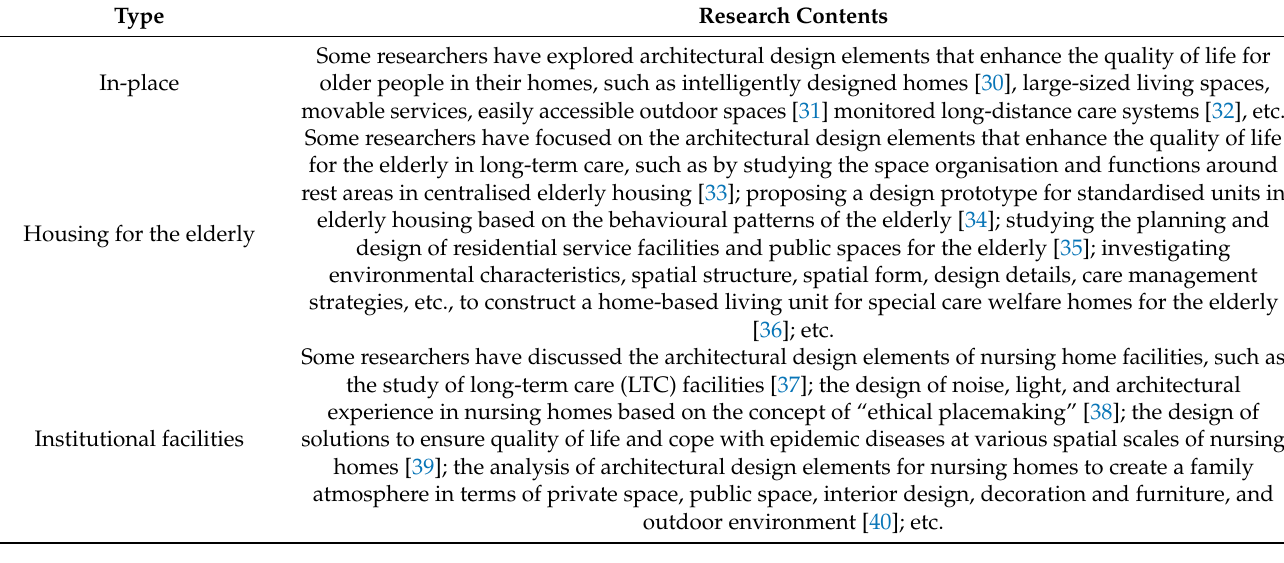
Figure 1. Schematic diagram of the type structure for FCMNCE. Table 2. Overview of research on the architectural design of service facilities for the